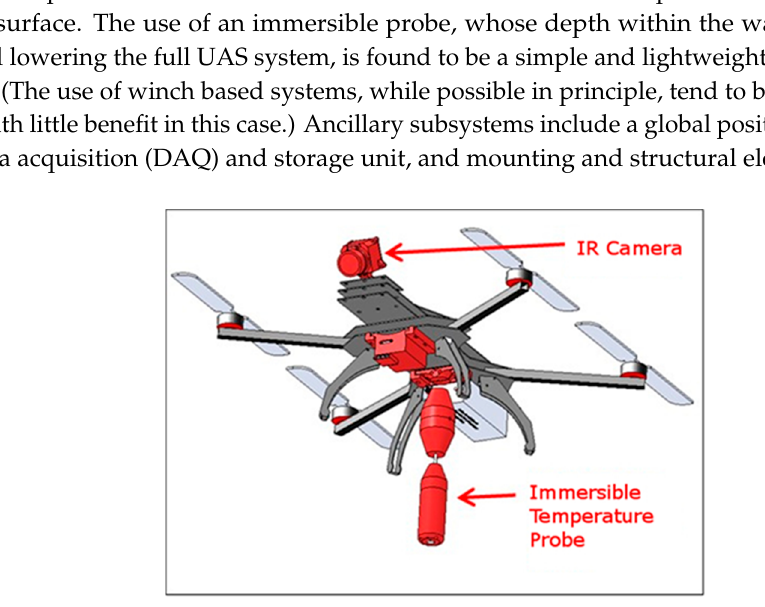
Figure 1. Overall design concept. The UAS flies over the thermal water plume using its navigational (auto-pilot) capabilities. Key components carried by the UAS include an IR camera for thermal imaging of the water surface, an immersible probe that can be lowered and raised to measure the vertical temperature profiles below the water surface, and a controller that stores the data.